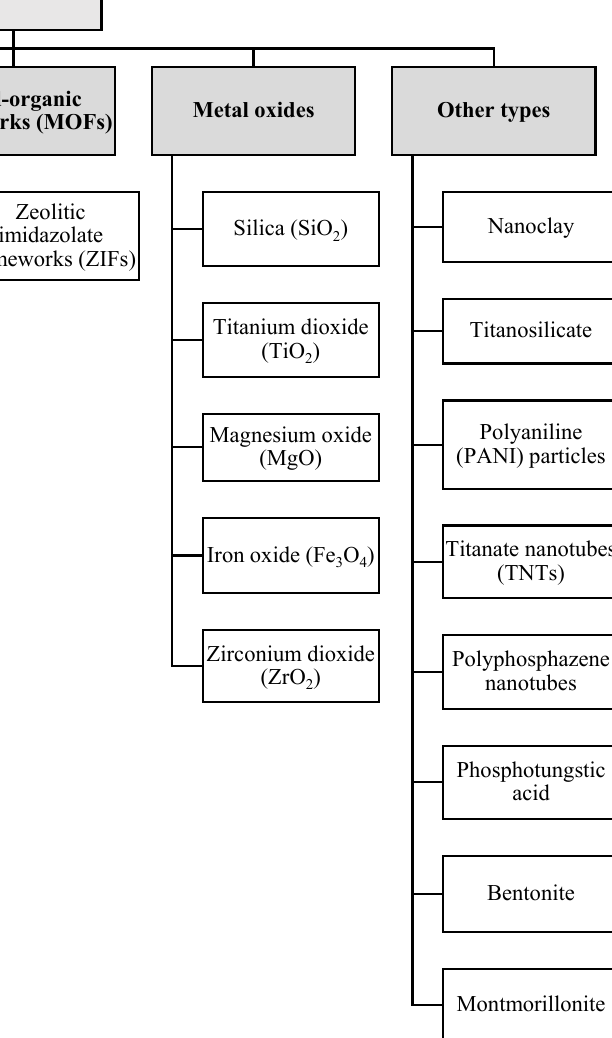
Figure 3. Different types of nanofillers applied in the preparation of nanocomposite PV membranes. Table 1. PV nanocomposite membranes used in different applications.